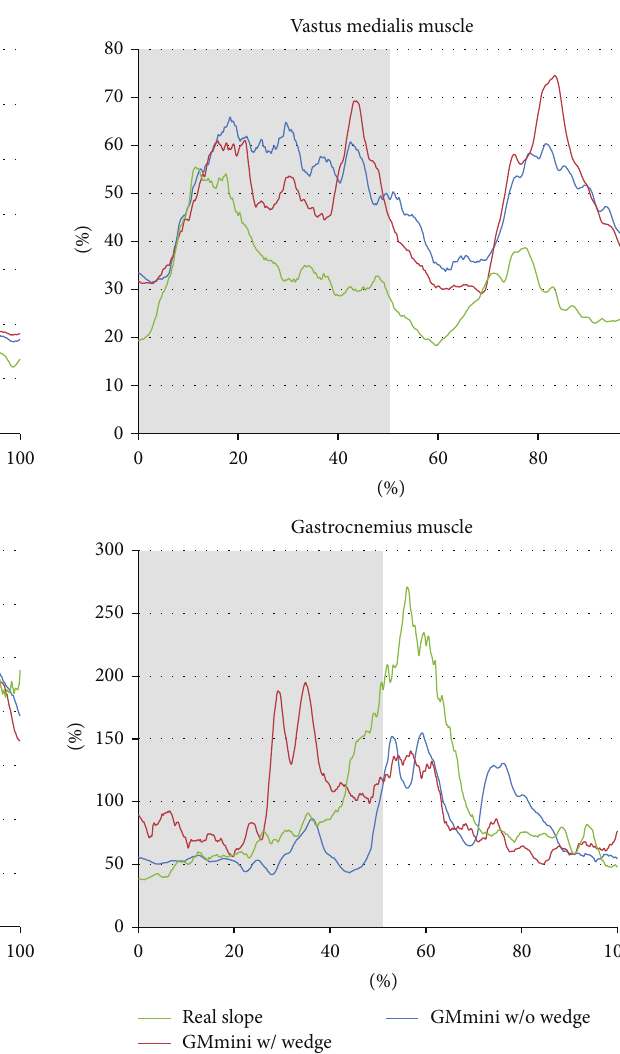
hamstrings, which are an antagonist of the vastus medialis muscle, were also active. The reason for this is that the subjects tended to stiffen the knee joint during the stance phase when descending the slope in order to prevent